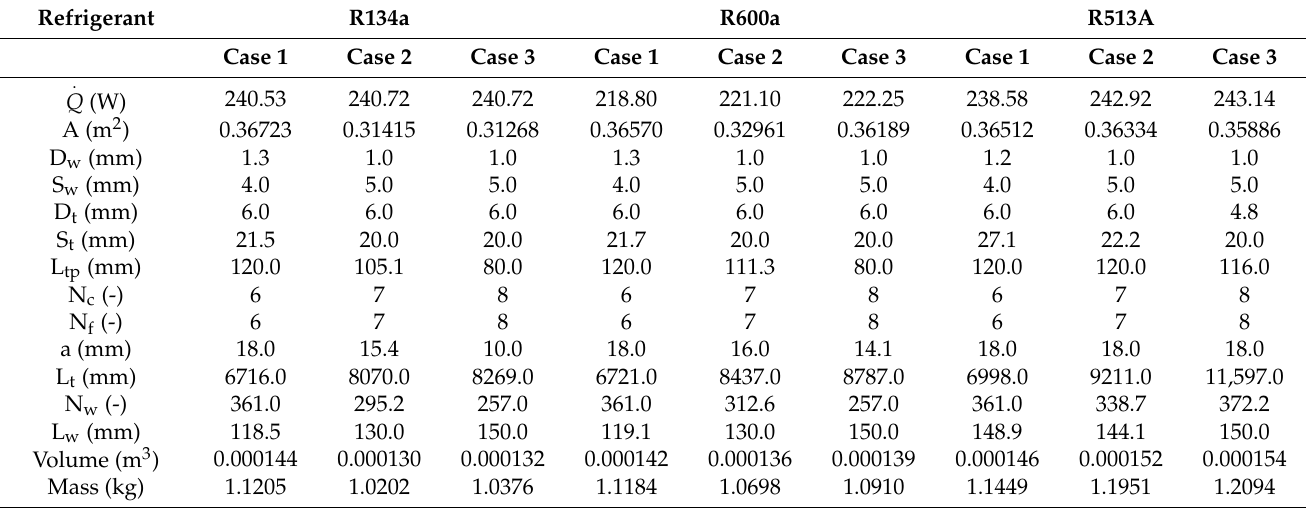
Table 4. Optimal geometric designs of the three respective refrigerants for each case